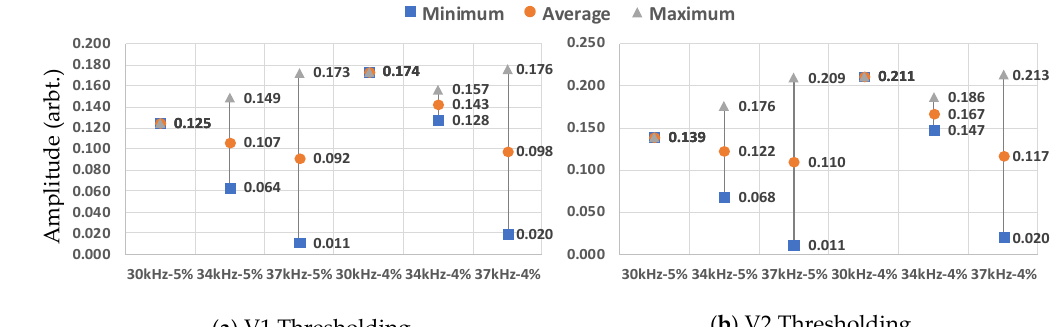
Figure 18. Limits achieved using method two on the second set of tests.